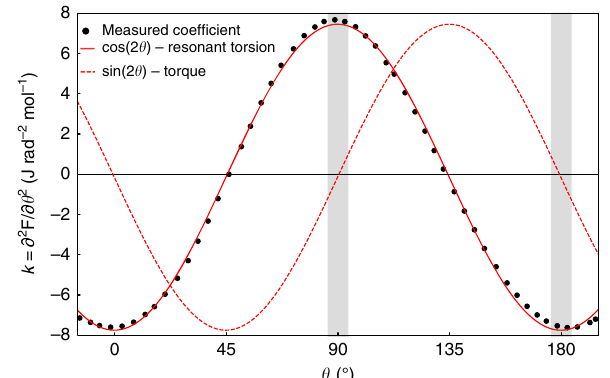
Fig. 2 Angle dependence of the magnetotropic coef fi cient. The magnetotropic coef fi cient k , proportional to the shift in frequency, of RuCl 3 at T = 16 K and B = 5 T (black points). The expected angle dependences of the magnetotropic coef fi cient (solid red line) and the magnetic torque (dashed red line) in the linear response regime M i = χ ij B j are overlaying the data. θ = 0° and θ = 90° correspond to magnetic fi eld applied perpendicular and parallel to the honeycomb planes, respectively. In the linear response regime, the principal magnetic axes (gray bands) have a maximal response in the magnetotropic coef fi cient, and these directions coincide with the zeros of the torque